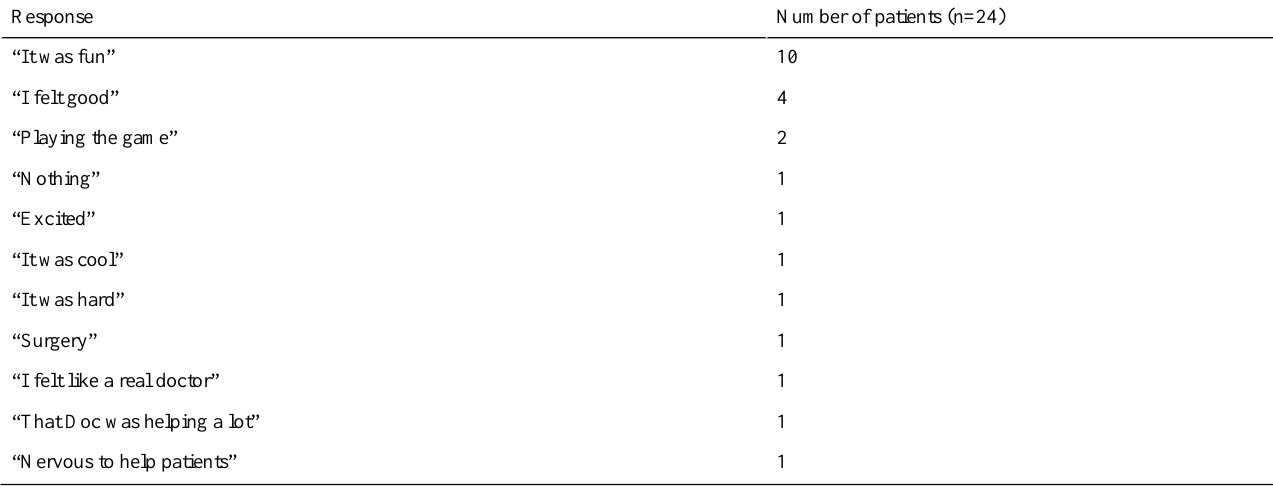
Table 1. Patients’ thoughts during gameplay with DocVR, in response to the question “What did you think about during ‘Doc McStuffins: Doctor for a Day?’”